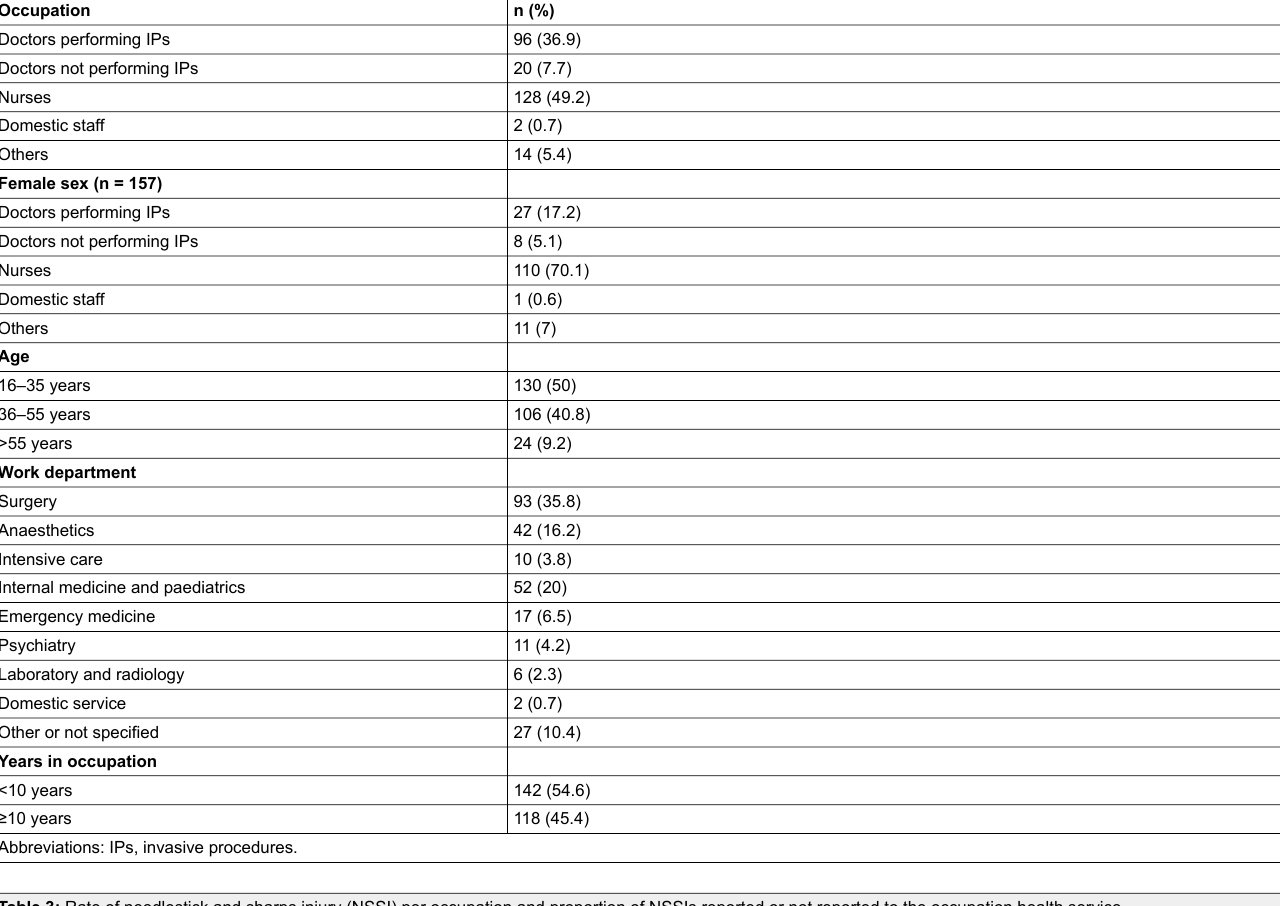
Table 2: Descriptive characteristics of the 260 healthcare workers who sustained one or more needlestick and sharps injury (NSSI).